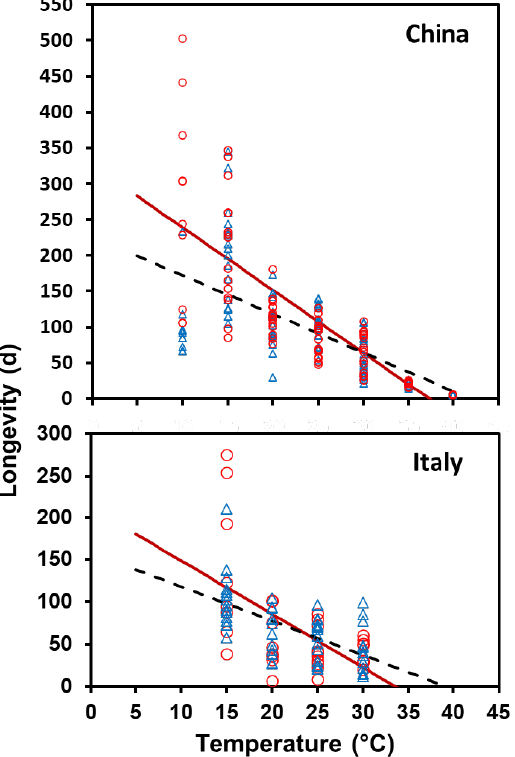
Figure 1. Relationship between temperature and longevity for male and female A. chinensis from China and Italy. Observed male data are open triangles, observed female data are open circles, predicted male dashed line, and predicted female solid line.